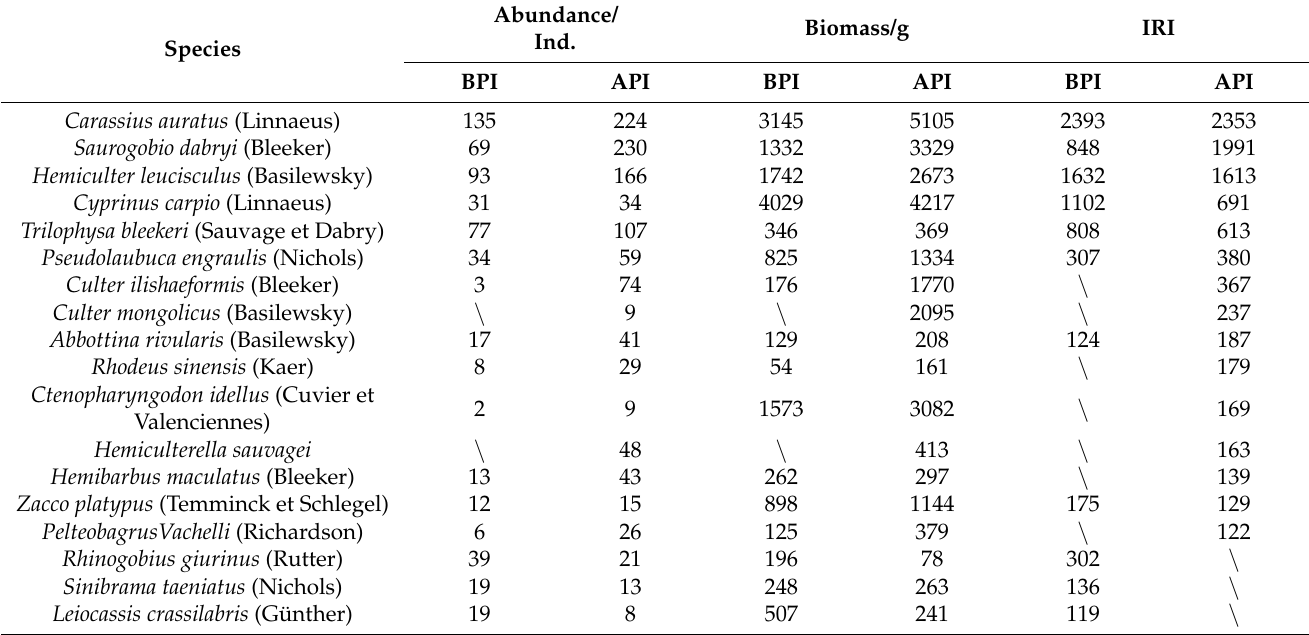
Table 2. Dominant and common species before and after project implementation, and their corre- sponding abundance and biomass. Species with IRI > 1000 were considered dominant species while species with 100 ≤ IRI < 1000 were defined as common species. “BPI” is the abbreviation of “before the implementation”; “API” is the abbreviation of “after project